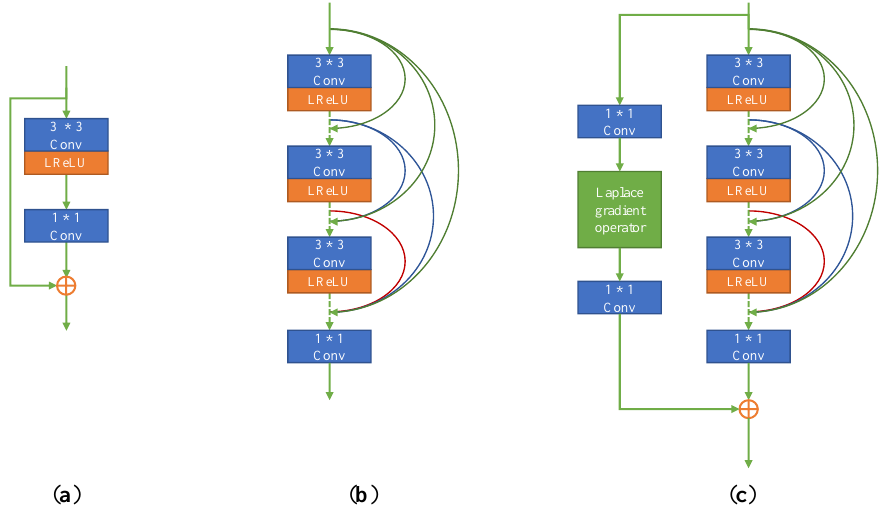
Figure 2. A schematic of three deep learning architectures, ( a ) Residual block; ( b ) Dense block; ( c ) Dense residuals with Laplacian gradient operators.